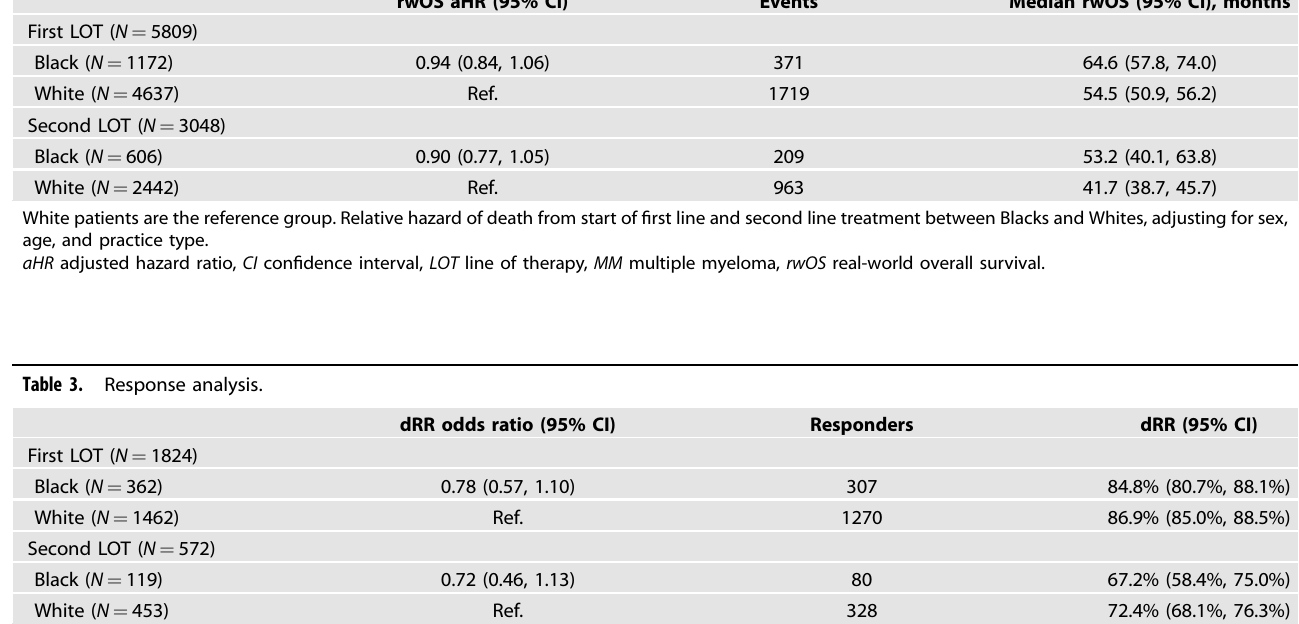
White patients are the reference group. Relative odds of responding to fi rst line and second line treatment between Black Patients and White Patients, adjusting for sex, age, and practice